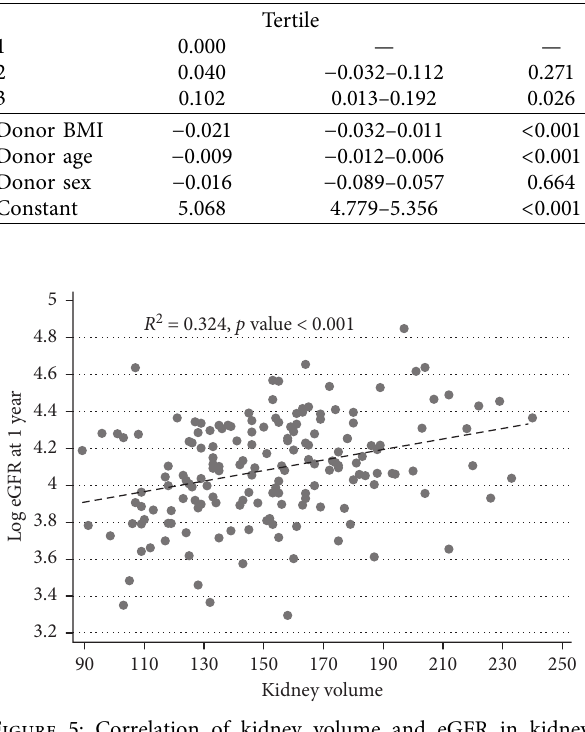
Figure 5: Correlation of kidney volume and eGFR in kidney transplant recipients at 1 year after